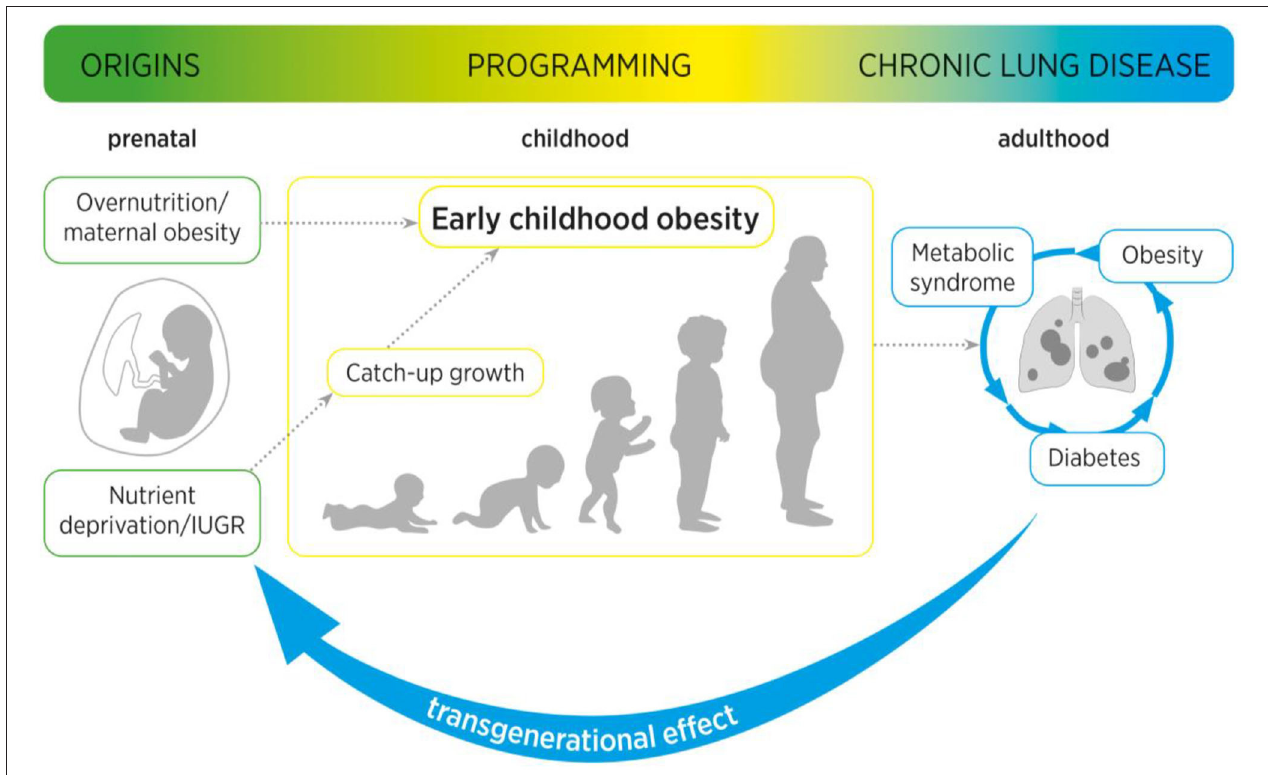
FIGURE 2 | Maternal obesity as well as intrauterine growth restriction (IUGR) increase the risk of (catch-up growth mediated) early childhood obesity. Maternal and early childhood obesity are associated with long-term adverse metabolic effects, including type 2 diabetes mellitus and metabolic syndrome. These pathological metabolic processes are not only intimately linked to an increased risk for pulmonary diseases, but can cause a transgenerational effect from mother to child, to second-generation